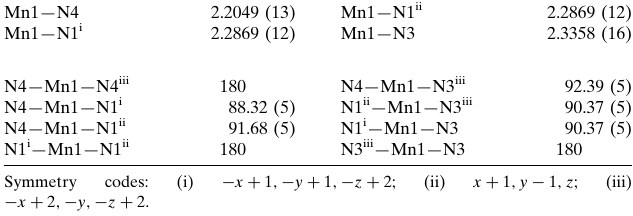
Selected geometric parameters (A˚ , (cid:3) ).